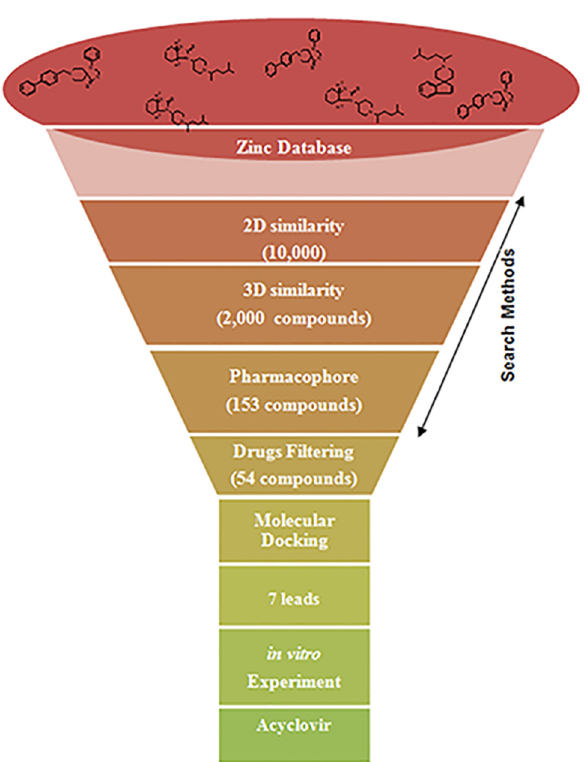
Fig 1. The workflow of the virtual screening protocol for screening of similar drugs to